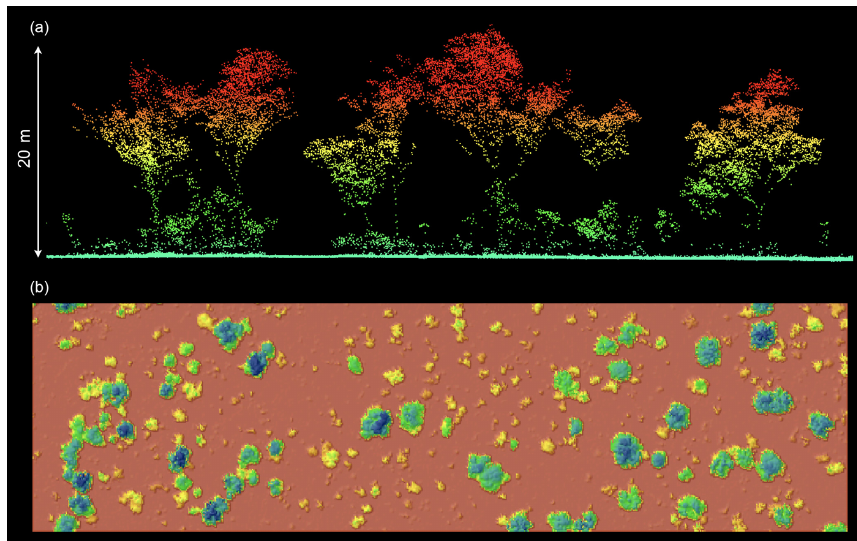
Figure 2. Cross section through the normalized high-resolution lidar point cloud (a) and aerial view of rasterized canopy height model (CHM) interpolation (b) . The lidar point cloud provided excellent representation of both the vertical and horizontal structures of vegetation across the site.